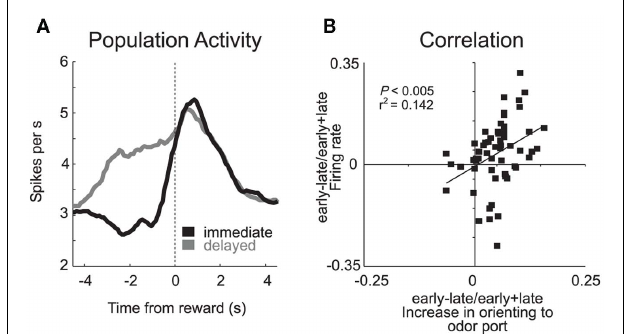
FIGURE 3 | Basolateral amygdala (ABL). (A) Average firing rate for all reward-responsive neurons in ABL on the last 10 trials during immediate (gray) and delayed (black) reward after learning. (B) Activity in ABL was correlated with odor port orienting as defined by the speed at which rats initiated trials after house light illumination during the first and last 10 trials in blocks 2–4.These data were normalized to the maximum and inverted. Error bars indicate SEM (adapted from Roesch et al.,